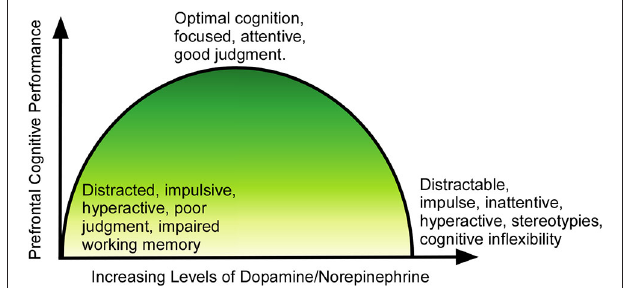
FIGURE 2 | Relationship of dopamine/norepinephrine to prefrontal function. At lower than optimal levels, the PFC is underactive, and the individual suffers from symptoms of ADHD (impulsivity, poor judgment, inattentiveness, motor hyperactivity). As levels rise, the function improves, until cognition and executive function reaches peak performance at optimal levels of dopamine/norepinephrine. As levels of the neurotransmitters continue to rise past the optimal point, cognition again becomes impaired, with the individual showing distractability, impulsivity, stereotypical behaviors and cognitive